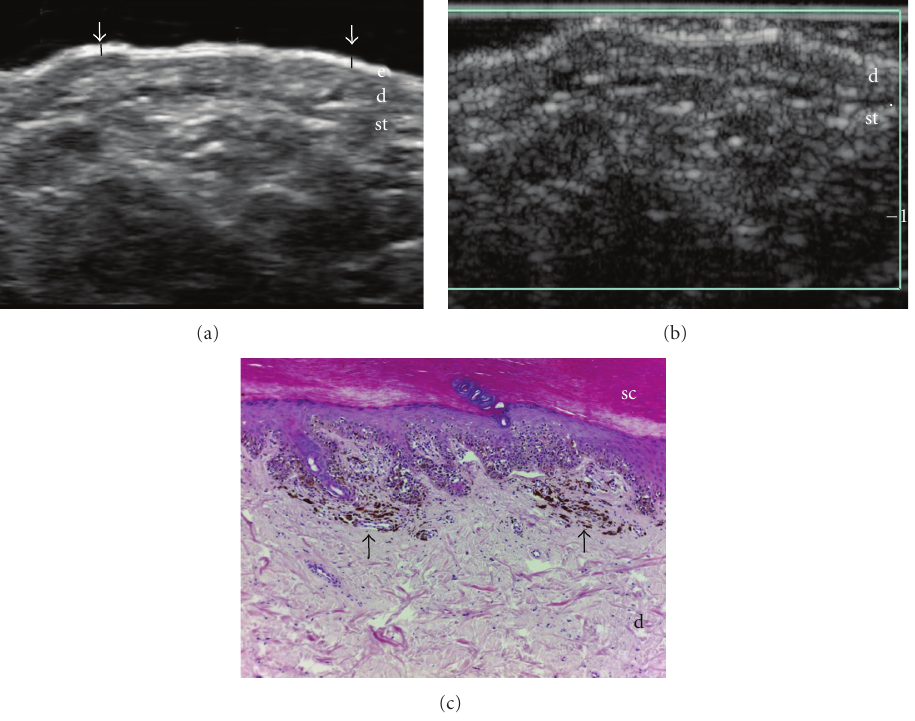
Figure 1: Melanoma in situ. (a) Ultrasound (transverse view, plantar region) shows lack of detectable solid tumor. Notice the partial loss of the normal bilaminar hyperechoic pattern of the plantar epidermis in parts of the lesion (arrows). (b) Color Doppler ultrasound demonstrates lack of hypervascularity at the lesional site. (c) Histology (HE × 100, acral skin, courtesy of Dr. Laura Carre˜no, Department of Pathology, Hospital Clinico Universidad Chile, University of Chile, Santiago, Chile) shows atypical nests of melanocytic cells within the epidermis (in situ). At the dermis there are some melanophages (arrows). Abbreviations: sc: stratum corneum; d: dermis; st: subcutaneous